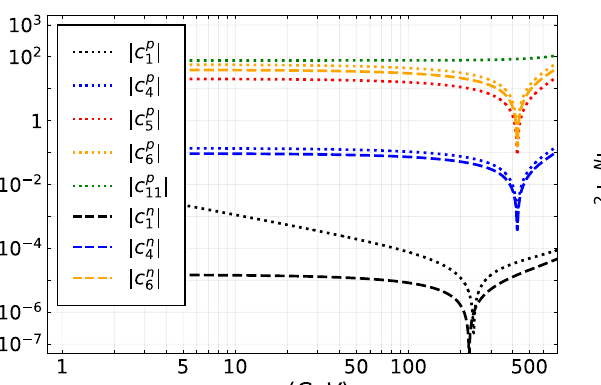
Xe at E R = 8 . 59 keV and are displayed ficients are evaluated for 132 54 in dimensionless units by rescaling with the square of the electroweak VEV v = 246 . 2